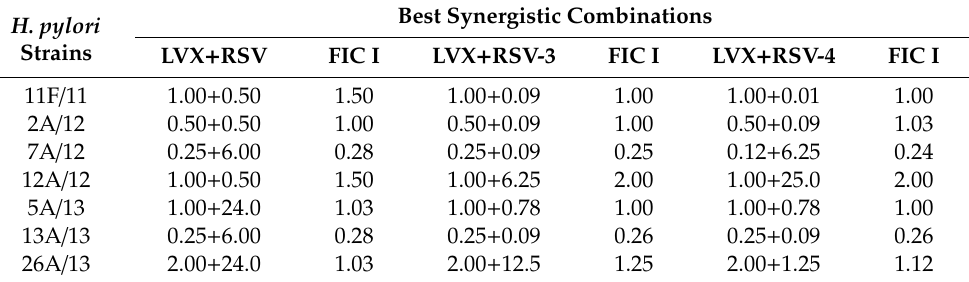
Table 2. Best combinations ( µ g / mL) of RSV, RSV-3 and RSV-4 and LVX with the values of FIC Index (FIC I) for resistant H. pylori clinical strains.